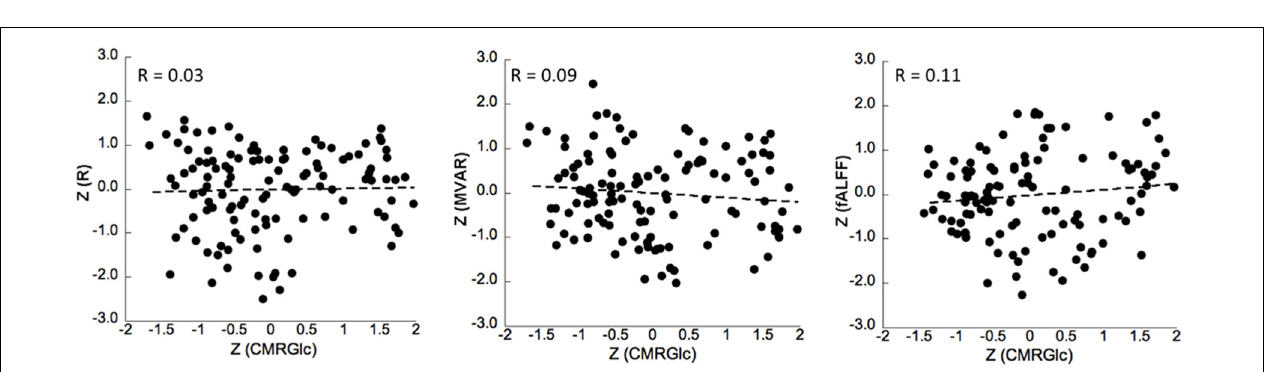
FIGURE 3 | (A) Test-retest values of R coefficients in six major networks: Default Mode network (DMN), Salience network (Salience), R/L Executive network (R Exec/L Exec) and Attention network (Attention) and Sensory-motor network (Sens_Mot). (B) Corresponding test-retest values of MVAR coefficients in the same six major networks. R, bivariate-correlation coefficient; MVAR, Multi-Variate Auto-Regressive model coefficient.